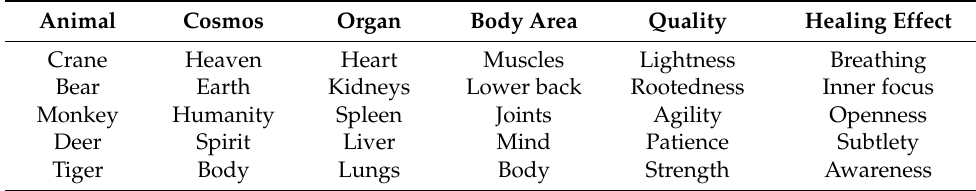
Table 3. Five Animal Frolics